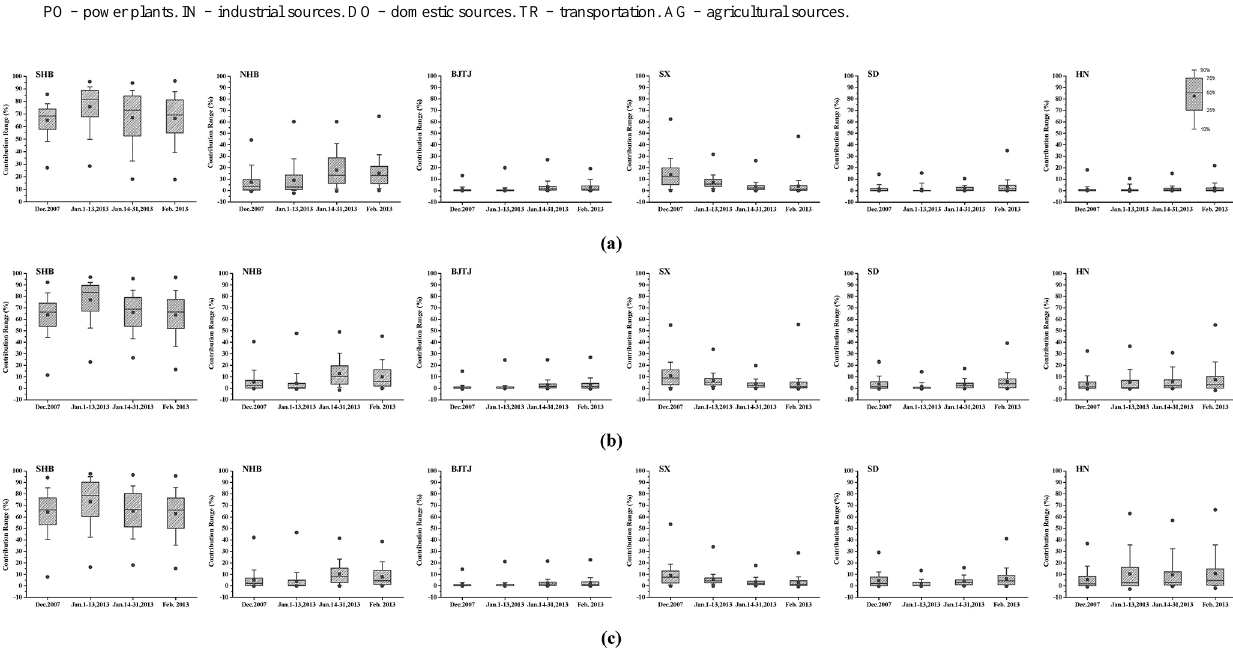
Fig. 9. The source contribution ranges by source regions to the PM 2 . 5 concentrations in (a) Shijiazhuang, (b) Xingtai, and (c) Handan in December 2007, and 1–13 and 14–31 January, and February, 2013. Dot signs indicate the maximum and minimum, and square signs indicate the average